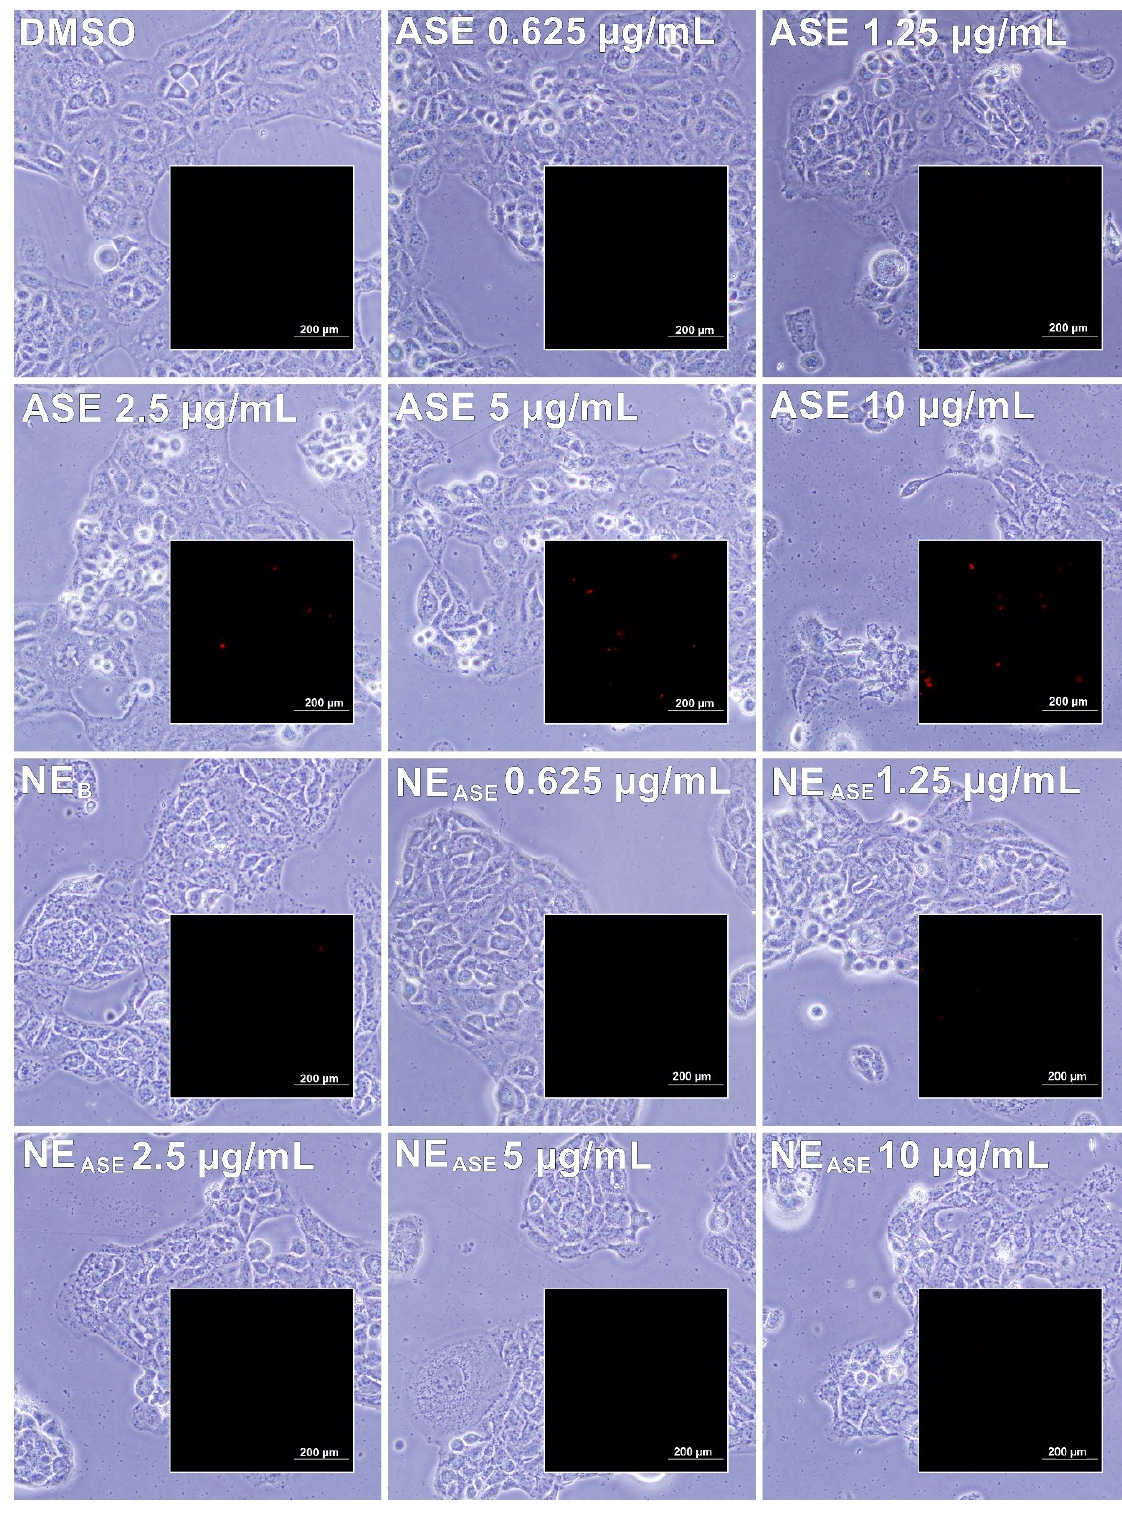
Figure 3. Phase contrast and fluorescence microphotographs (insert) of PI incorporation in HaCaT cells (immortalized human keratinocytes) after 24 h of treatment with ASE and NE ASE at 0.625, 1.25, 2.5, 5, and 10 µg/mL concentrations. Appropriate vehicle controls with DMSO 0.01% ( v / v ) and NE B were performed for ASE and NE ASE treatments, respectively. ASE : Achyrocline satureioides extract; NE ASE : Achyrocline satureioides extract-loaded nanoemulsion; NE B : blank nanoemulsion.